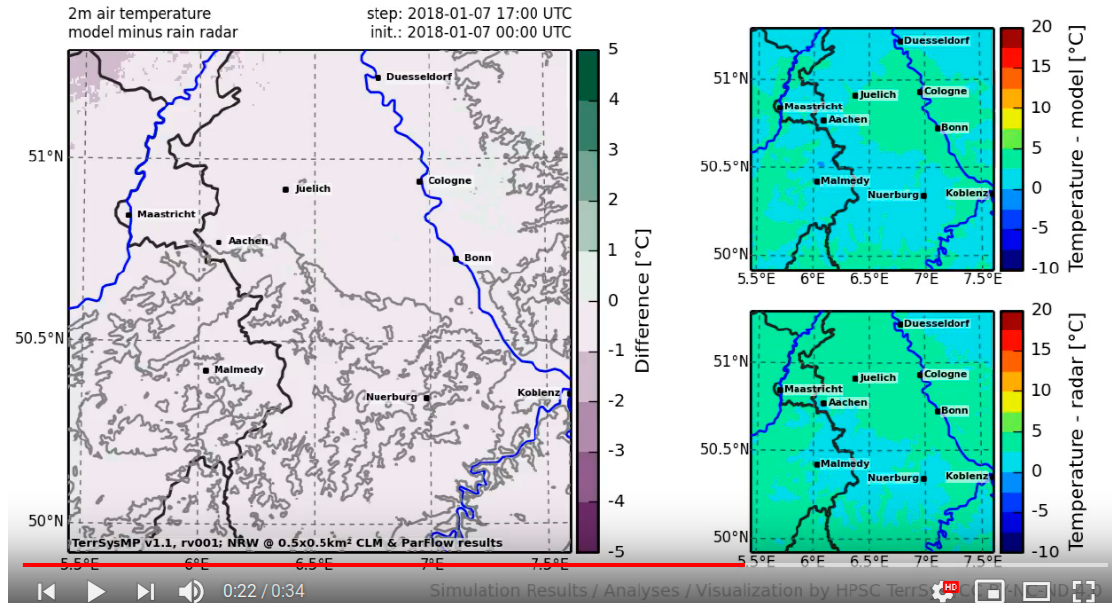
Figure 11. Difference plot for 2 m air temperature (°C) between uncorrected and precipitation radar corrected simulations. The panels on the right show the temperatures from the uncorrected (top) and precipitation radar corrected simulations (bottom).